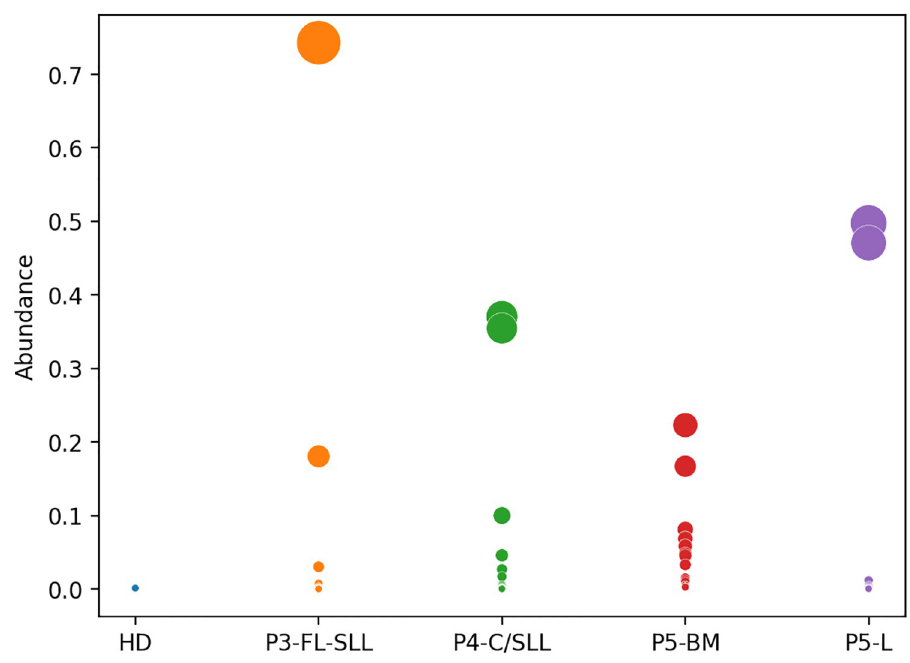
Fig 12. Clonal distributions of a healthy donor and individuals with different lymphoproliferative diseases. We plotted the 20 most abundant clonal lineages for each repertoire; Circles represent clonal groups, while their areas are proportional to the clonal group abundance. Report to Table 3 for repertoire properties and individuals’